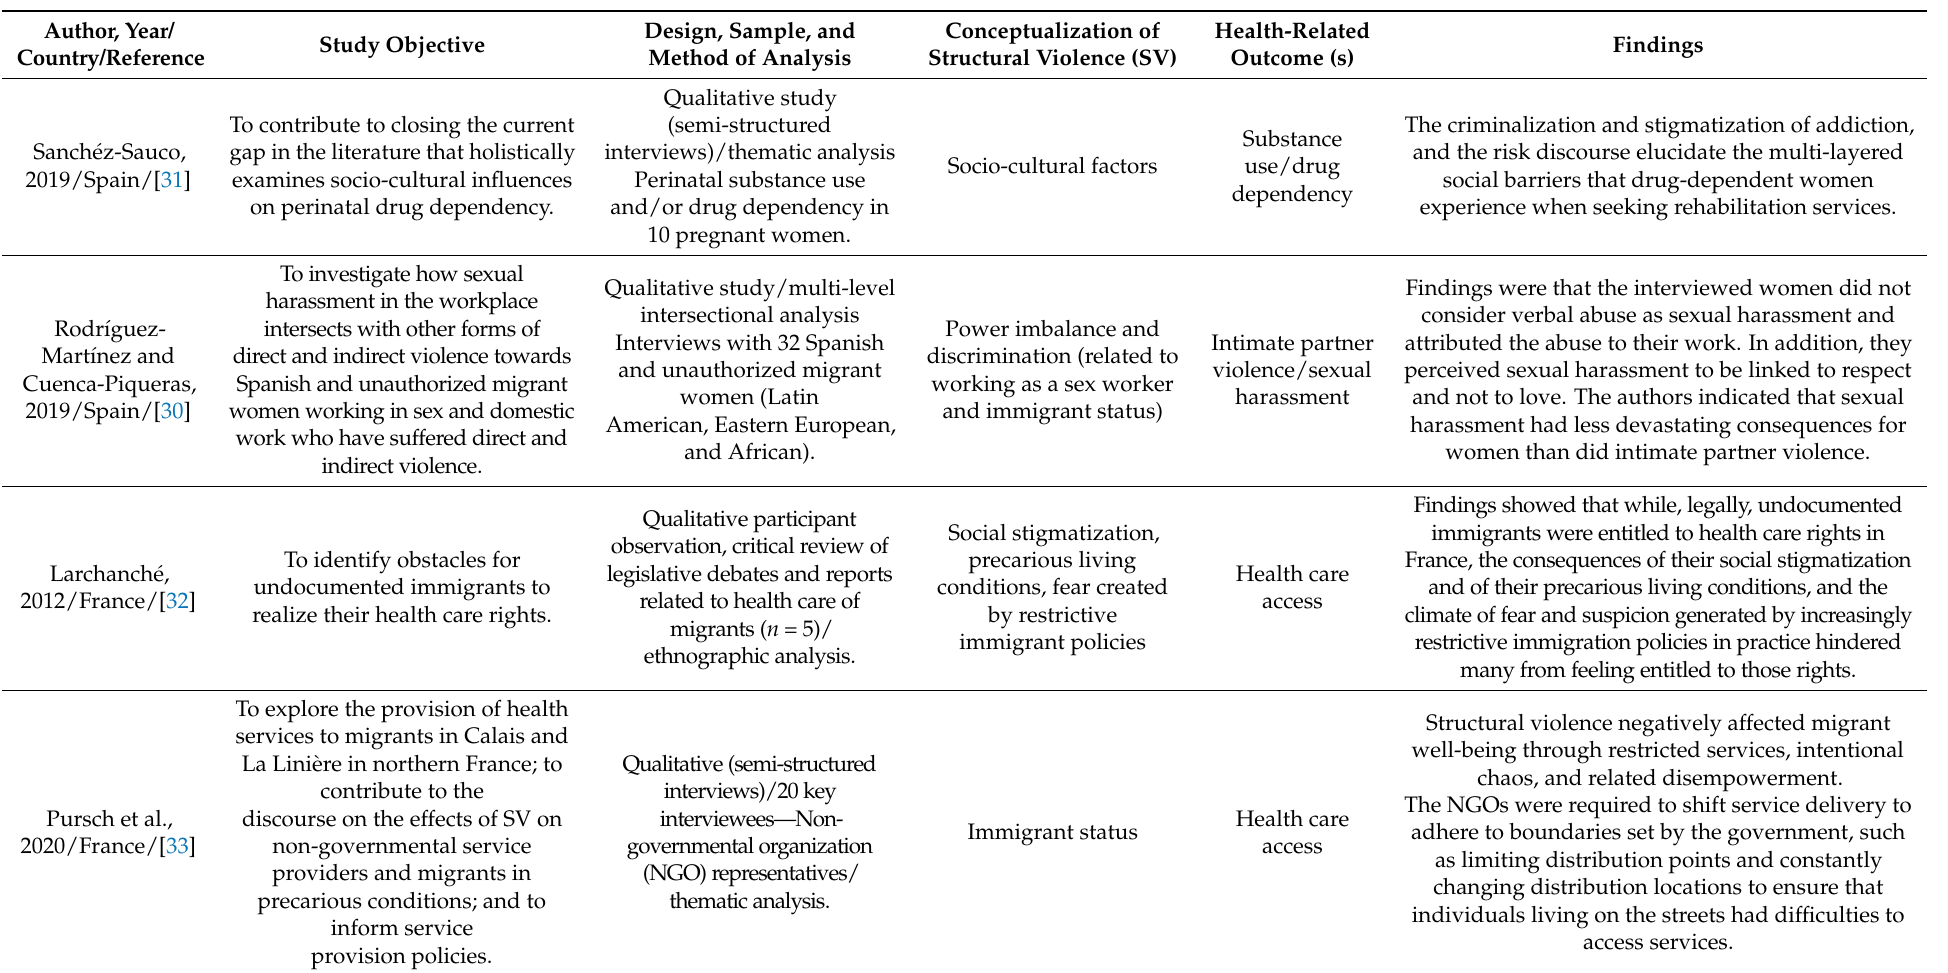
Table 1. Studies included in the review ( n =